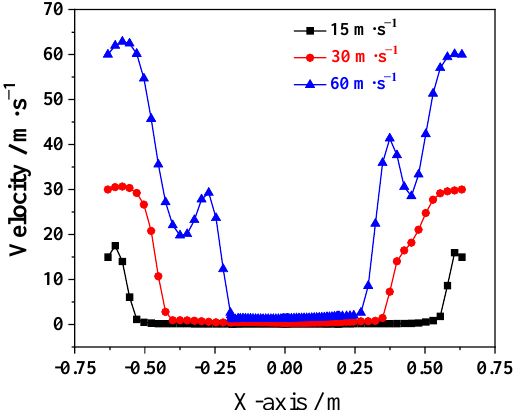
Figure 7. Velocity distribution in the x -axis direction under different inlet velocities (density: 1650 kg/m 3 , viscosity: 0.0055 Pa·s).